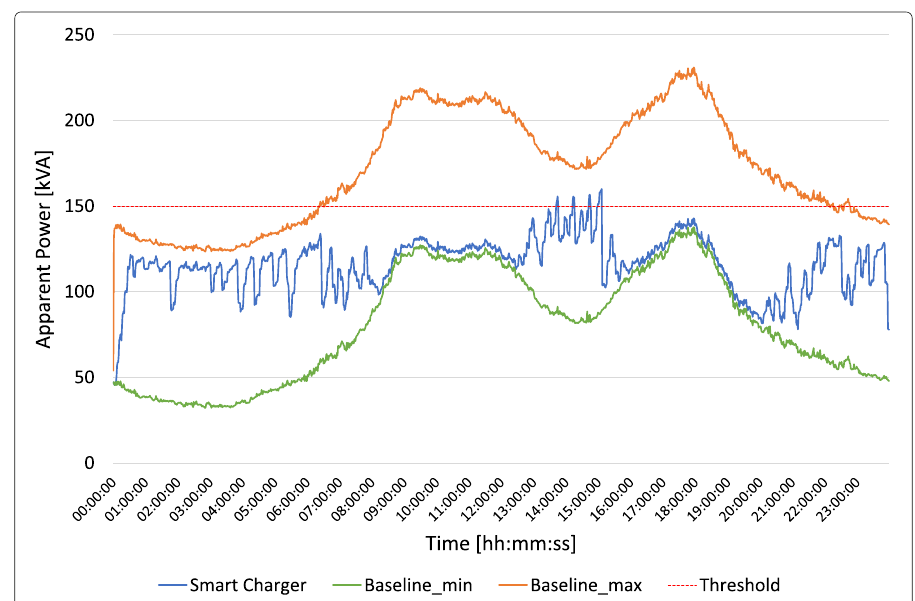
Fig. 9 Apparent power at the transformer station during a whole day. The orange and green line represent the baseline scenario, while the blue line shows the apparent power when all charging stations are controlled by our smart charging